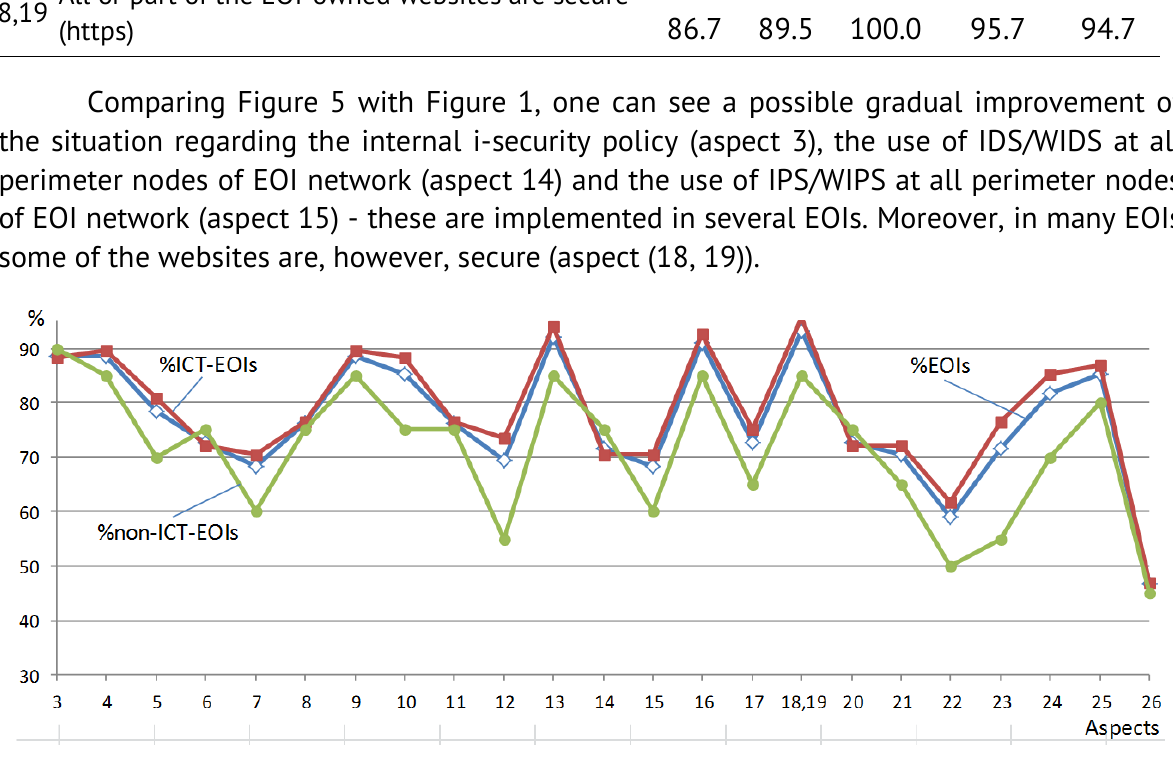
Figure 5. The %EOls, % ICT-EOls and %non-ICT-EOls dependence on aspects 3 – 26 at v100% i-security